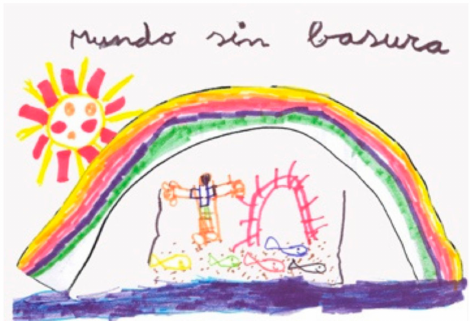
Figure 8. Logo referring to the sustainable local management model of the municipality. Approved by the monitoring commission and designed by ten-year-old children, “world without rubbish”.